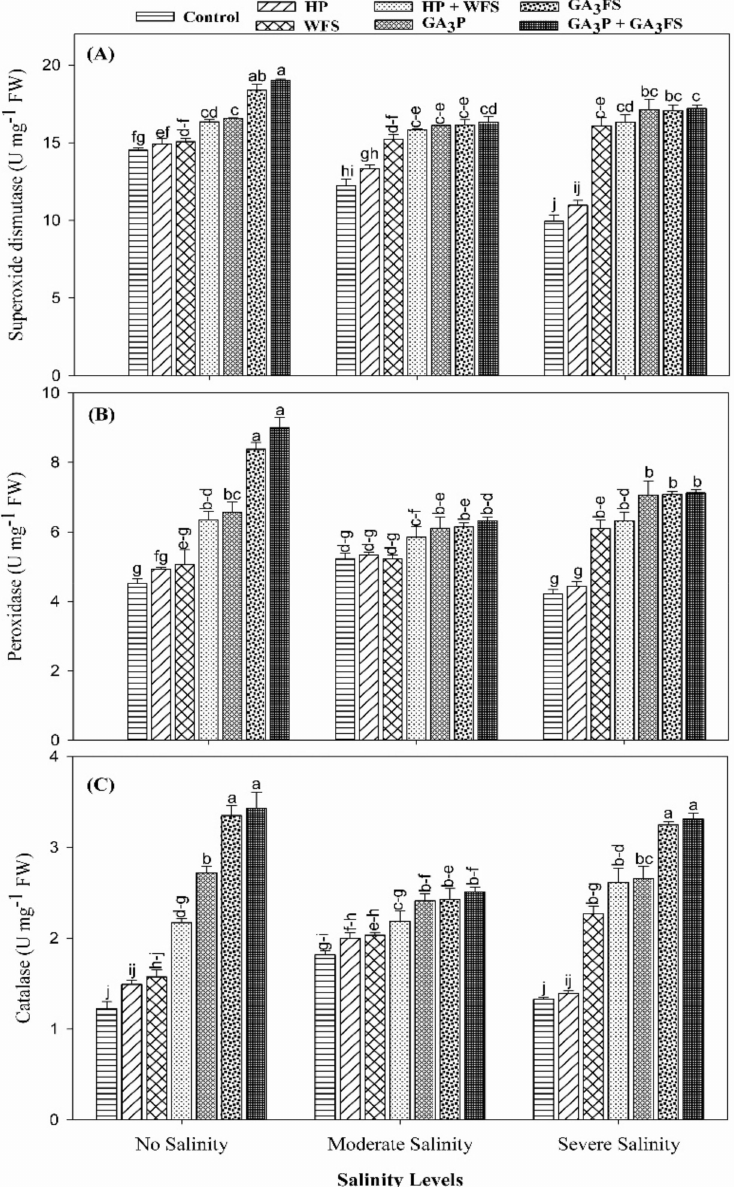
Figure 5. Superoxide dismutase ( A ), peroxidase ( B ) and catalase ( C ) activity in maize leaves as affected by different treatments of gibberellic acid under no salinity (control), moderate salinity (6 dS m − 1 ), and severe salinity (12 dS m − 1 ). Values are means ± SD (n = 3). Hydropriming (HP); water foliar spray (WFS); hydropriming and water foliar spray (HP + WFS); seed priming with GA 3 (GA 3 P); foliar spray with GA 3 (GA 3 FS); seed priming and foliar spray of GA 3 (GA 3 P + GA 3 FS). Bars with the same letters do not differ significantly at p ≤